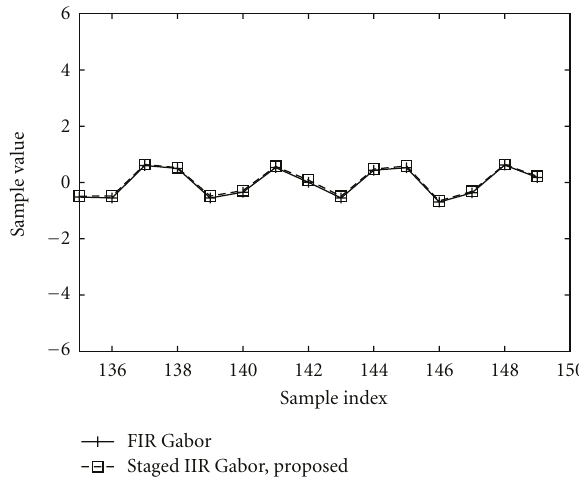
Figure 6: The forward-backward transitionfor the staged Gabor fil- tering initiates correctly when compared to an FIR implementation. Compare it with Figure 2. Only real parts of the complex filtering results are shown